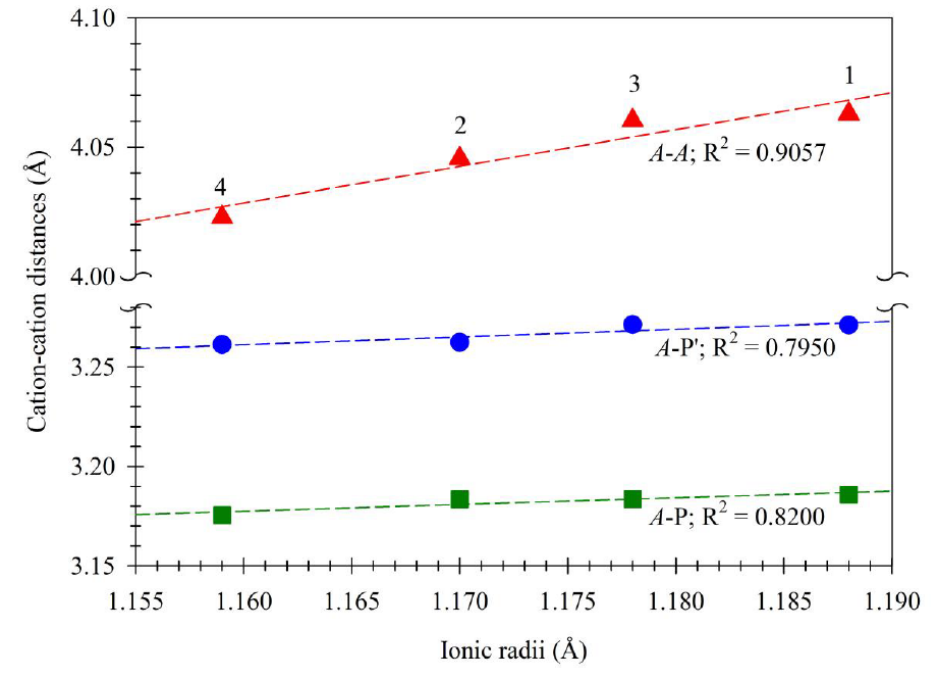
Figure 5. Variations of cation–cation distances with weighted average ionic radii for the A site cations. Linear dashed lines are fits to data from this study.